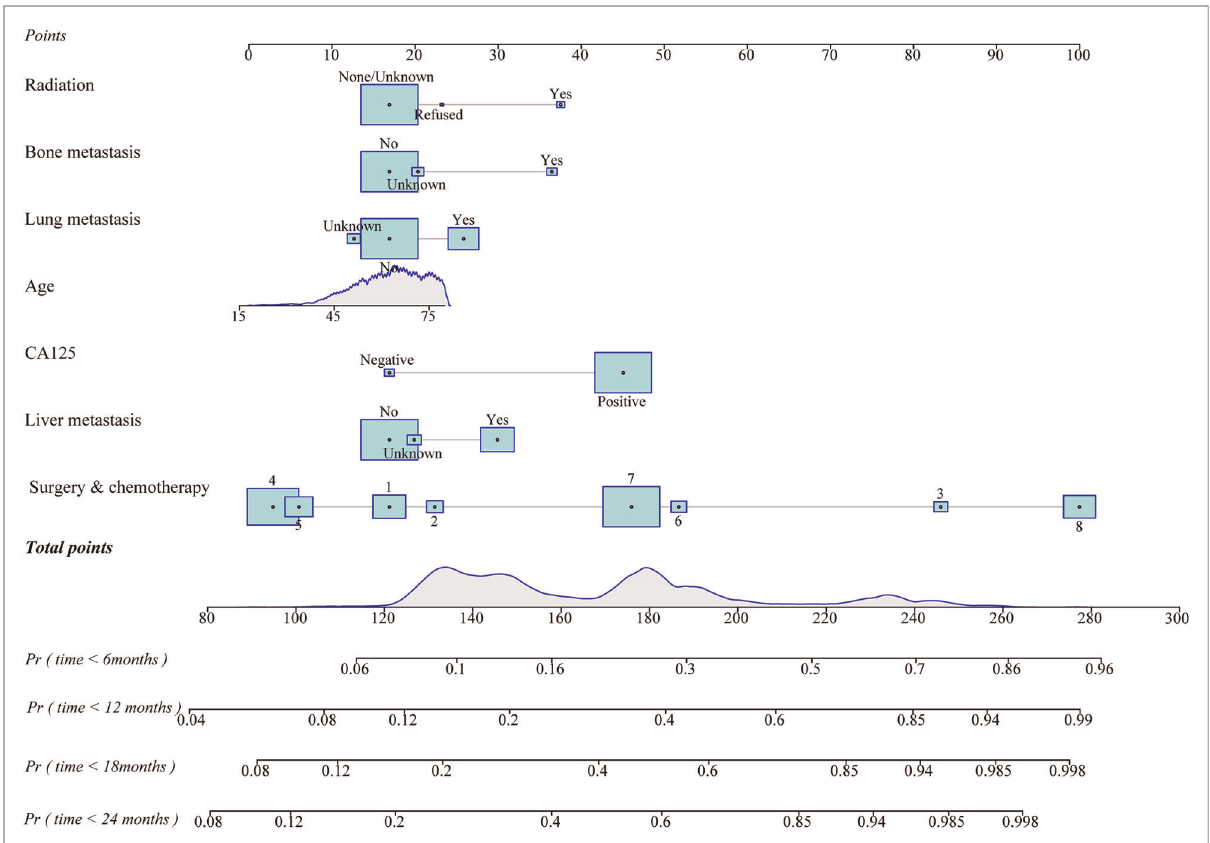
FIGURE 6 The nomogram of the prediction model for overall survival of metastatic ovarian cancer patients at different time points (1. unsatis fi ed surgery and post-operative chemotherapy, 2. unsatis fi ed surgery and pre-operative chemotherapy, 3. unsatis fi ed surgery and no/unknown chemotherapy, 4. satis fi ed surgery and post-operative chemotherapy, 5. satis fi ed surgery and pre-operative chemotherapy, 6. satis fi ed surgery and no/unknown chemotherapy, 7. without surgery but with chemotherapy or without surgery and 8. no/unknown